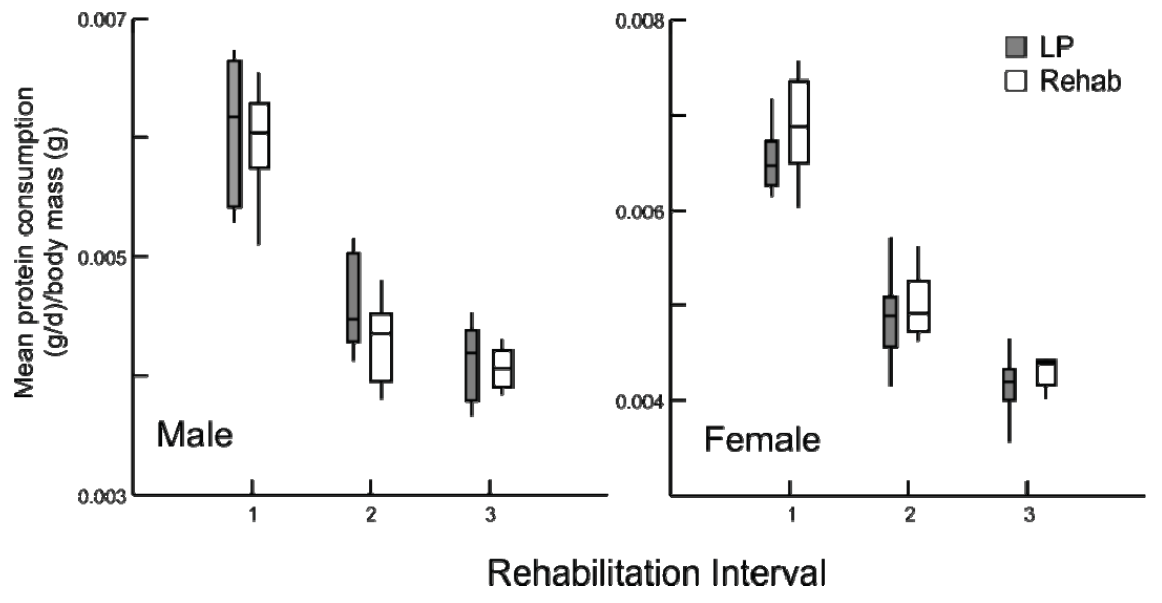
Figure 4. Daily average protein consumption (g/day) by body mass (g) for chronic LP and rehabilitation animals for 10 days prior to diet alteration. Rehabilitation